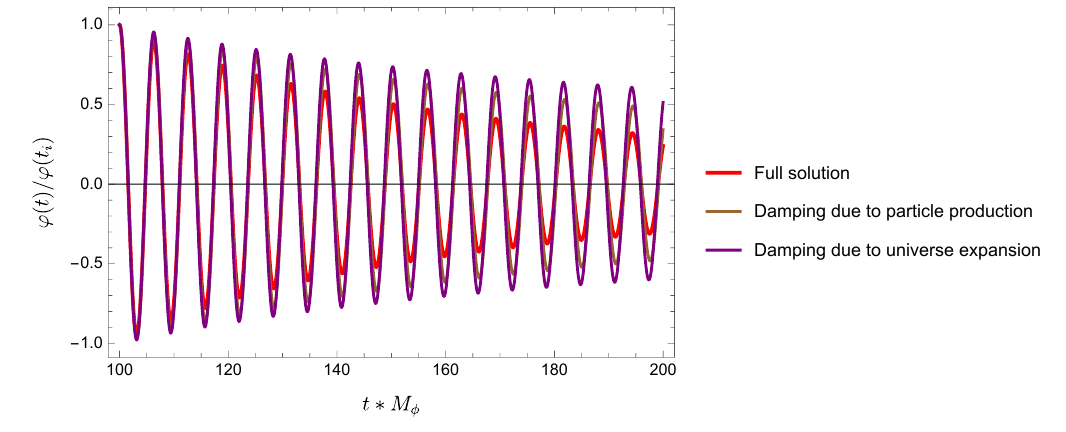
Figure 5 . Solutions of the condensate eq. (2.24). Analytic approximation in a radiation-dominated universe, i.e., eq. (3.50), is drawn in the red line with σ = − α = 0 . 01 /M ϕ , µ = 0 . 001 M φ , γ = 0 . 005 M ϕ , and λ φ = 0 . 05 . Analytic approximation in a static universe, given by eqs. (3.29) and (3.30), is drawn in the brown line with the same parameters. Analytic approximation without interactions in a radiation-dominated universe, i.e., eq. (3.40), is drawn in the purple line.